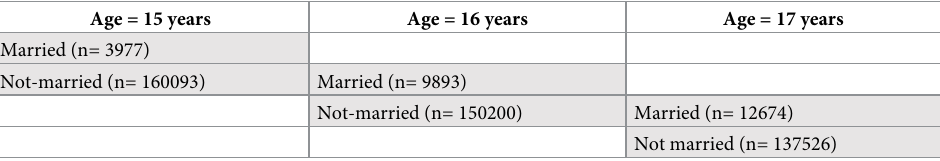
Table 1. Marital status and age